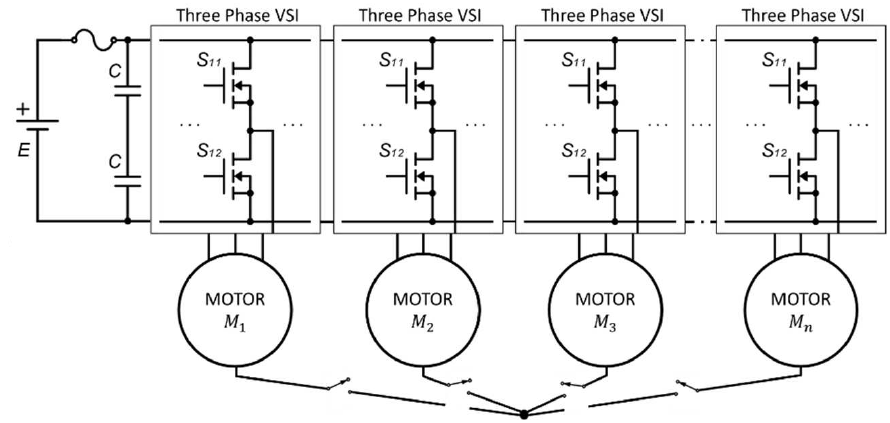
Figure 9. SPCM topology applied to an n motor system [69].